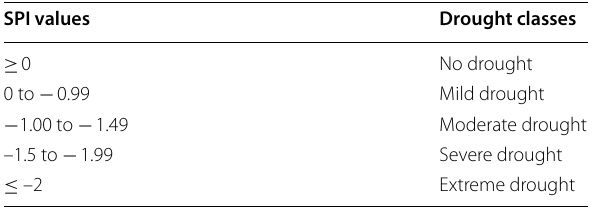
Table 2 Drought classes and corresponding standardized precipitation index values